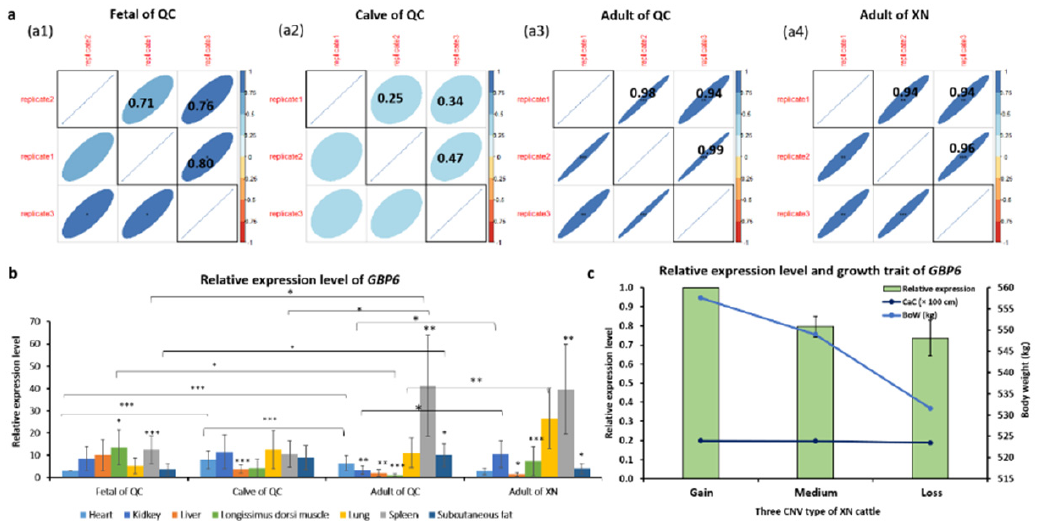
Figure 4. Relative gene expression levels of GBP6 . Note: *, ** and *** indicates p value < 0.05, < 0.01 and < 0.001, respectively. QC: Qinchuan breed; XN: Xianan breed; CaC: Cannon circumference; BoW: body weight. ( a ) PCCs of three replicates of relative expression levels of QC fetuses (a1), QC calves (a2), QC adults (a3) and XN adults (a4). ( b ) Relative expression levels among seven tissues. ( c ) Relative